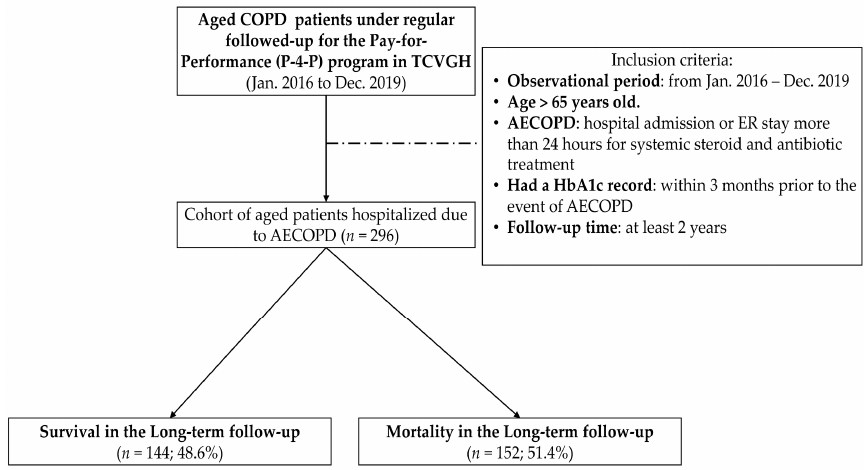
Figure 1. Enrollment and follow-up of the study participants. AECOPD: Acute exacerbation of COPD; COPD: chronic obstructive pulmonary disease; HbA1c: hemoglobin A1c. TCVGH: Taichung Veterans General Hospital; P-4-P: Pay-for-performance.